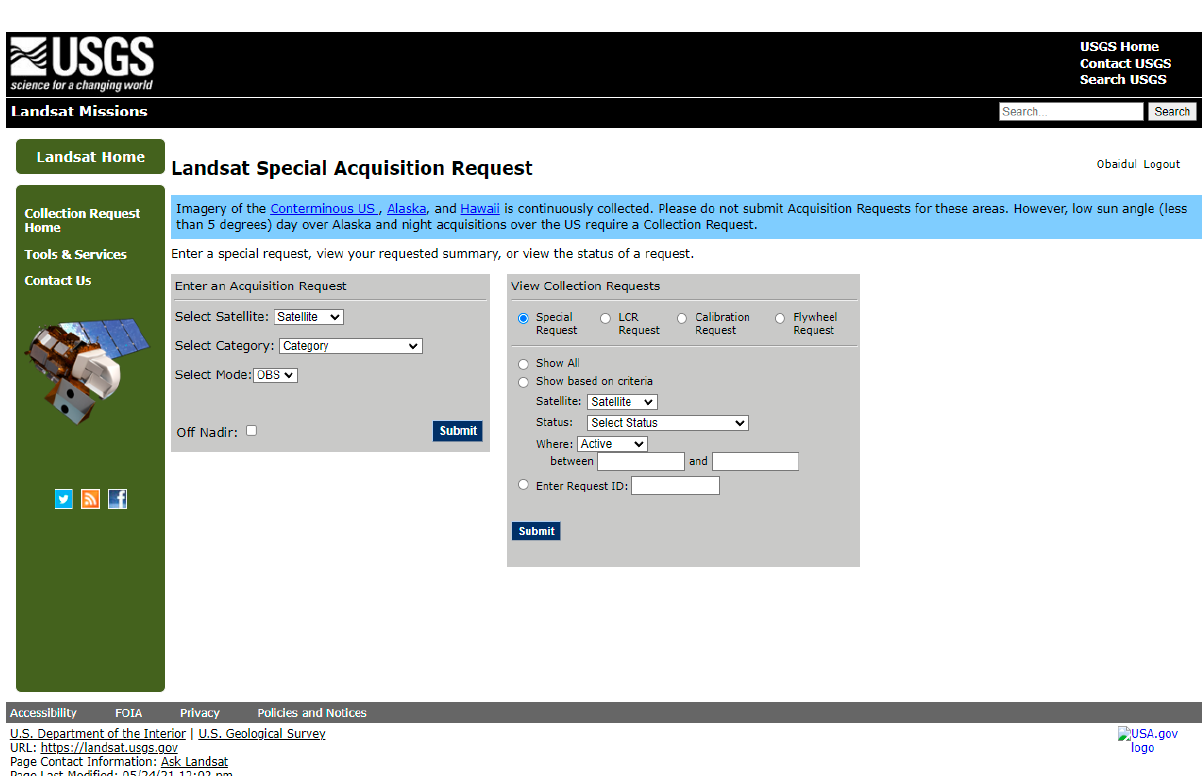
Figure 8. Landsat 9 User Portal Element (UPE) User Interface .